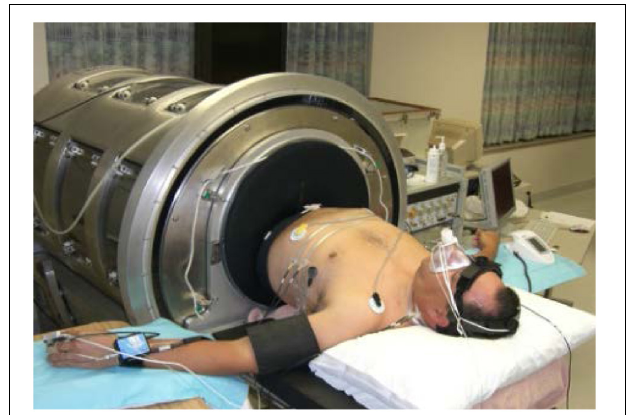
FIGURE 1 | Photograph of subject in the LBNP